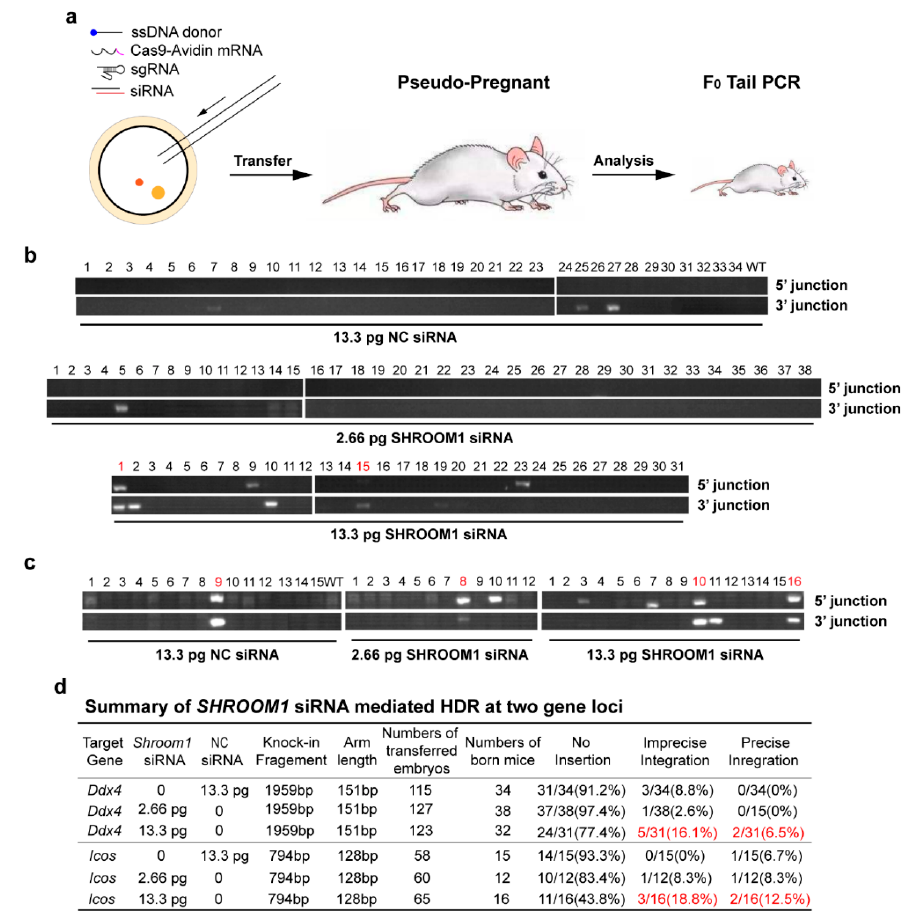
Figure 4. Knockdown of SHROOM1 enhances the knock-in efficiency of mouse embryos. ( a ) Experimental design of micro-injection. Cas9-Avidin mRNA, sgRNA, biotin-ss donor, and siRNA were injected into mouse zygotes and the injected zygotes were transferred to pseudo-pregnant mice for genotyping analysis. Genotyping of Ddx4 locus ( b ) and Icos locus ( c ) in mice treated with SHROOM1 siRNA or NC siRNA after incision by CRISPR/Cas9; ( d ) Summary of SHROOM1 siRNA-mediated HDR at the Ddx4 and Icos loci. Results with significant differences are highlighted in red.